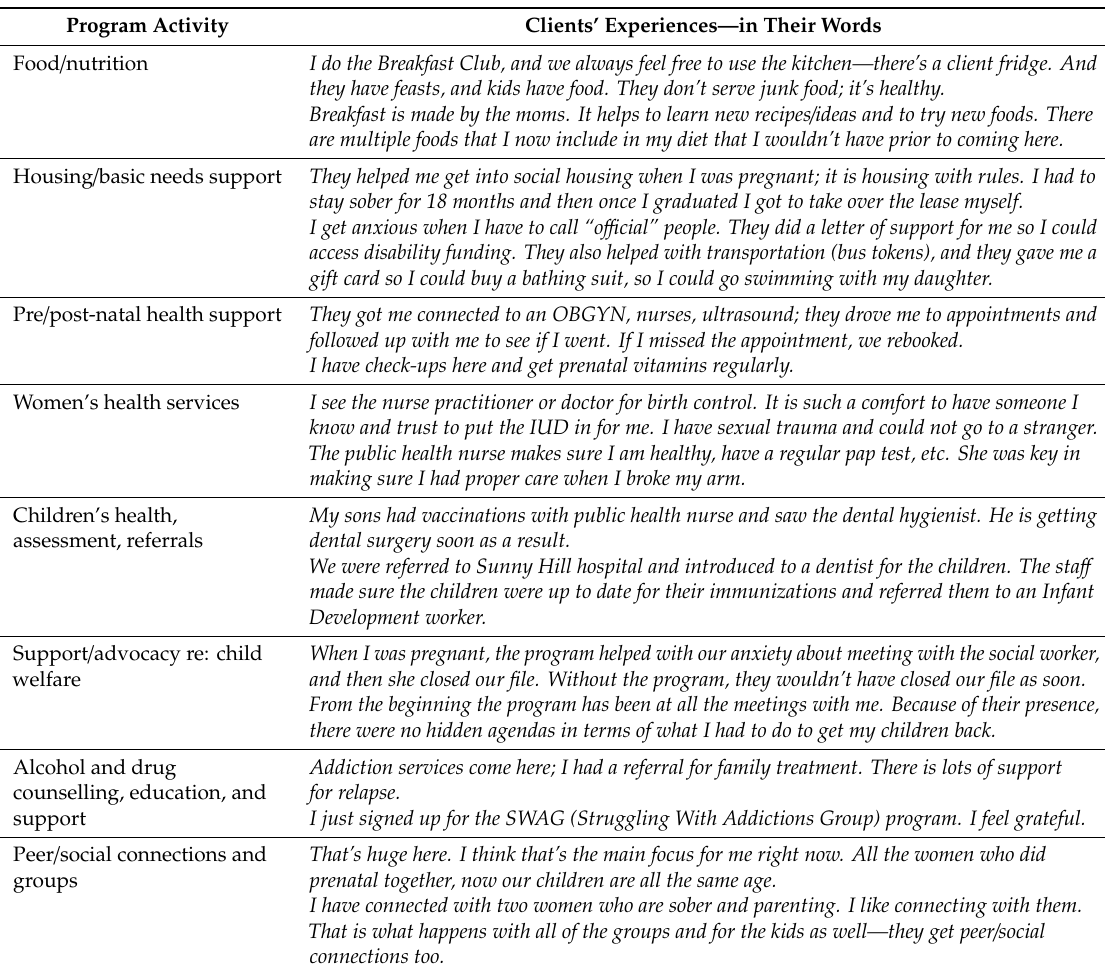
Table 3. Clients’ involvement in and experience of their program’s